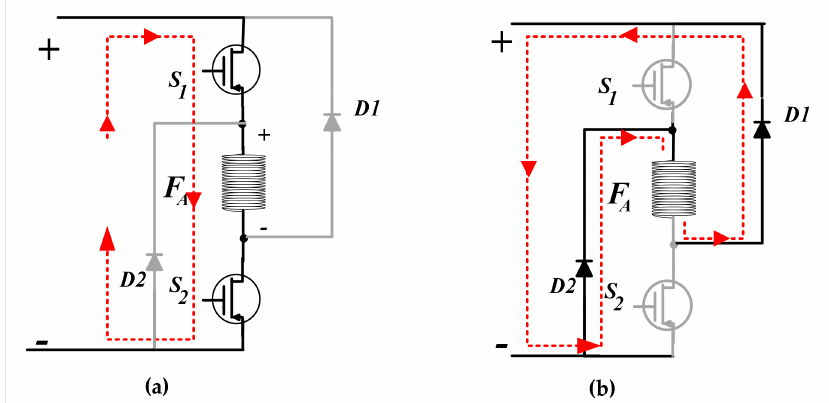
Figure 2. SRG operating modes ( a ) excitation mode and ( b ) generation